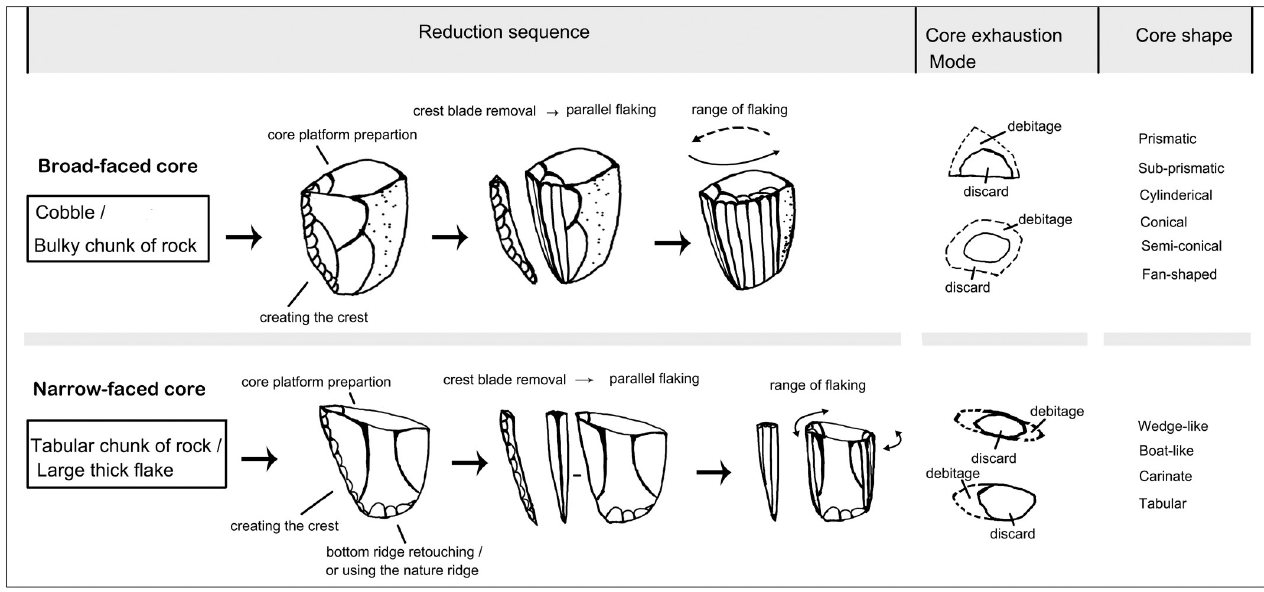
Fig 6. Illustration showing the reductional sequence of broad-faced core production and narrow-faced core production.